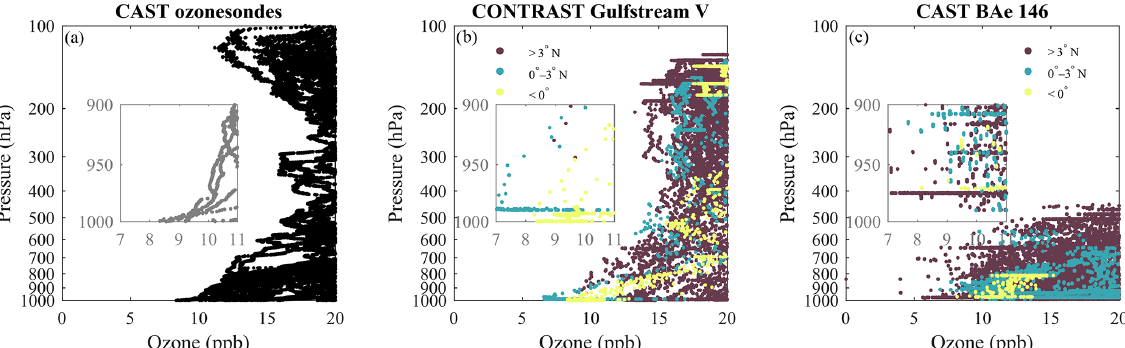
Figure 19. Complete dataset of ozone measurements from the CAST ozonesondes (a) , the CONTRAST Gulfstream V aircraft (b) and the CAST FAAM BAe 146 aircraft (c) , with the aircraft data split into the Southern Hemisphere measurements (yellow), Equator–3 ◦ N (blue) and higher Northern Hemisphere latitudes (purple). In all cases, minimum ozone near the surface was lower than minimum ozone in the mid-troposphere. The insets show the low ozone concentrations measured in the lowest 100hPa of the atmosphere in each case.